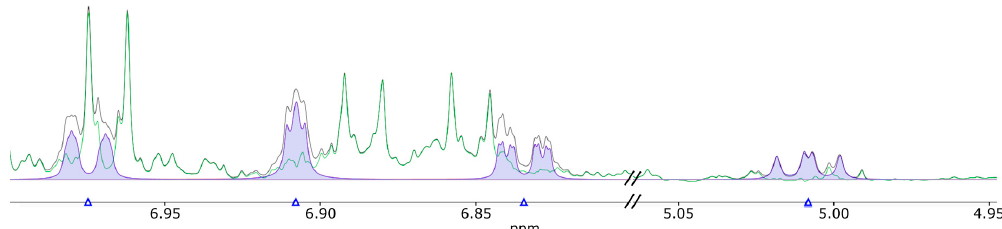
Figure 1. Extract of a profiled NMR spectrum of a typical human urine sample using Chenomx software suite. The black line represents the actual urine spectrum, while the green line represents the difference between the actual spectrum and the fitted spectrum. Highlighted in blue are the clusters of HPHPA between 7.00 and 6.80 ppm and the cluster at 5.00 ppm.